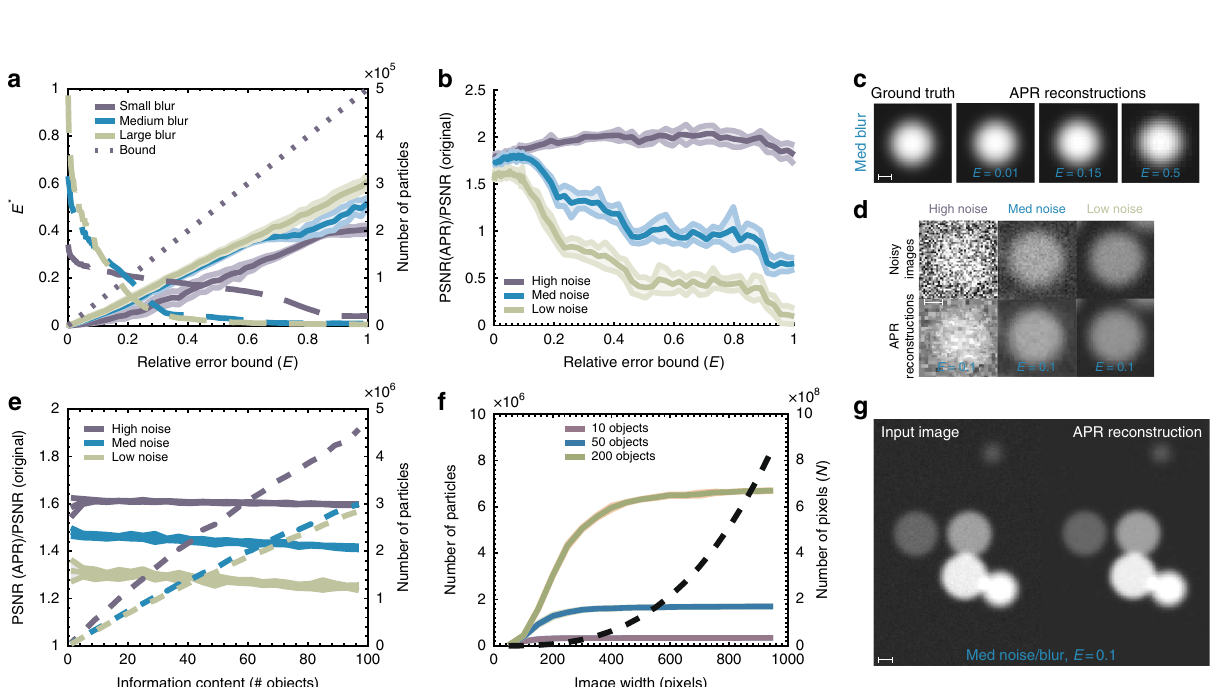
Fig. 2 Validation of the APR on synthetic data. All results are shown with mean (lines) and standard deviation (bands). a Observed reconstruction error E * (solid lines, left axis) between the ground truth and the piecewise constant APR reconstruction for noise-free images, and number of particles used by the APR (dashed lines, right axis) for different user-de fi ned error bounds E (original image, number of pixels N = 128 3 ≈ 2.1×10 6 ). Results are shown for images of different sharpness (blur). The APR reconstruction error is below the speci fi ed bound in all cases (dotted line). More accurate APRs require more particles. b Peak signal-to-noise ratio (PSNR) of the APR relative to the PSNR of the original pixel image for different error bounds E and image noise levels. For low E , the APR has a better PSNR than the input images. c APR reconstructions of the medium-blur noise-free test image at different E compared to the ground truth. d Examples of test images of spherical objects with different noise levels used in the benchmarks, comparing the original noisy images with their APR reconstructions for E = 0.1, illustrating the inherent denoising property of the APR. e PSNR ratio (solid lines, left axis) and number of particles used (dashed lines, right axis) for images containing different numbers of objects, i.e., different information content, for E = 0.1. In all cases, the PSNR of the APR is better than that of the input image, and the number of particles scales at most linearly with image information content (original image, number of pixels N = 300 3 = 2.7 × 10 7 ). f Number of APR particles (solid lines, left axis) and the fi xed number of input image pixels N (black dashed line, right axis) for images of different sizes containing a fi xed number of objects ( E = 0.1). The number of particles plateaus as soon as the objects in the image are well resolved. Scale bars indicate 10 pixels. For additional details, see Supplementary Note 16. g Visual comparison of a medium-blur, medium-noise image containing six objects (left) with its piecewise constant APR reconstruction (right) for E = 0.1. Note axis units are arbitrary unless otherwise given